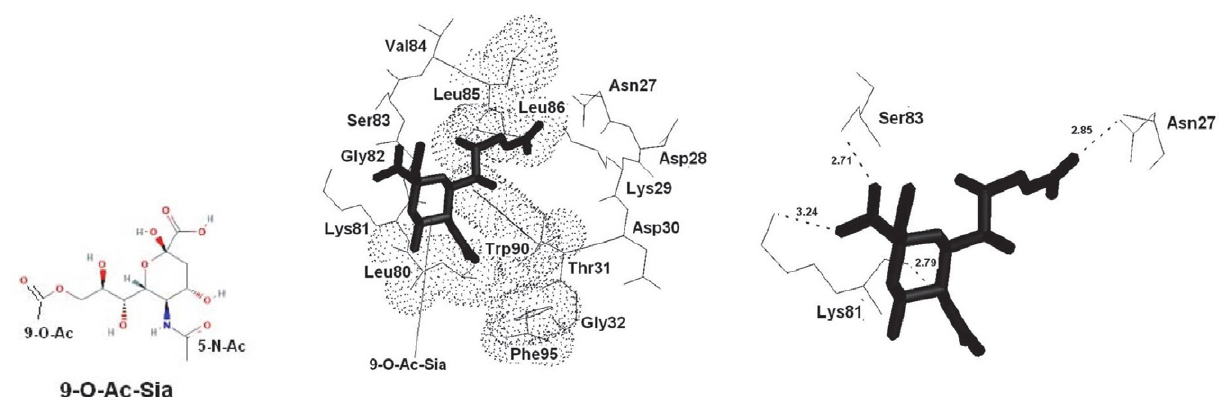
Figure 2. The chemical structure of 9-O-acetylated sialic acid (9-O-Ac-Sia) (left). 9-O-Ac-Sia (bold sticks) in interaction with the binding site resi- dues of hCoV-OC43 S (PDB ID: 6NZK). The P1 (Leu85, Leu86 and Trp90) hydrophobic pocket (dots) accommodates the 9-O-Ac-Sia methyl, while the P2 (Leu80, Trp90 and Phe95) hydrophobic pocket (dots) accommodates the 5-N-acetyl methyl (center). 4 electrostatic contacts of 9-O-Ac-Sia with Asn27, Lys81, Lys81 and Ser83, respectively